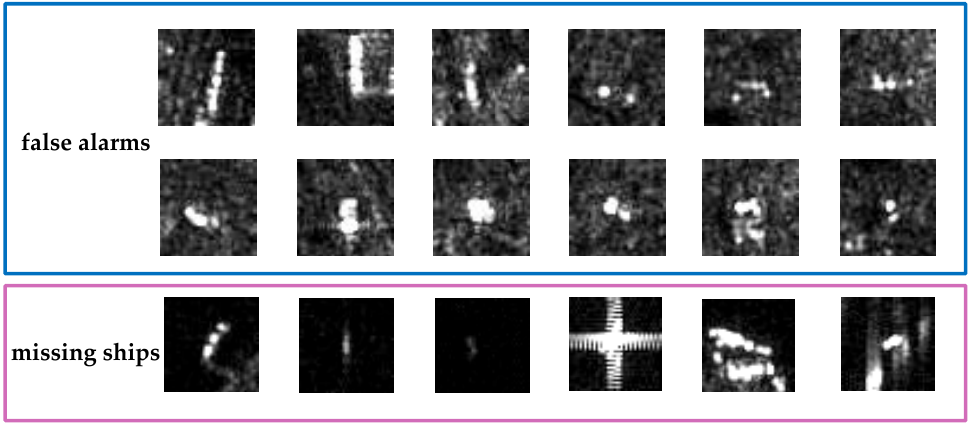
Figure 9. Some typical false alarms and missing detection targets among the detection results of the proposed method. The chips in the blue box and the purple box are false alarms and missing ships respectively.